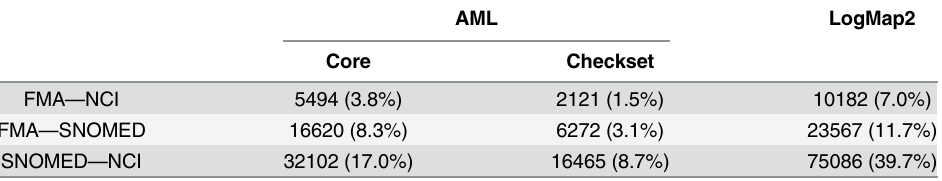
Table 2. Number of classes in AMLR ’ s core fragments and checksets, and in LogMap's extracted modules for each matching problem in the OAEI Large Biomedical Ontologies track. The percentage of classes relative to the original ontologies is shown in